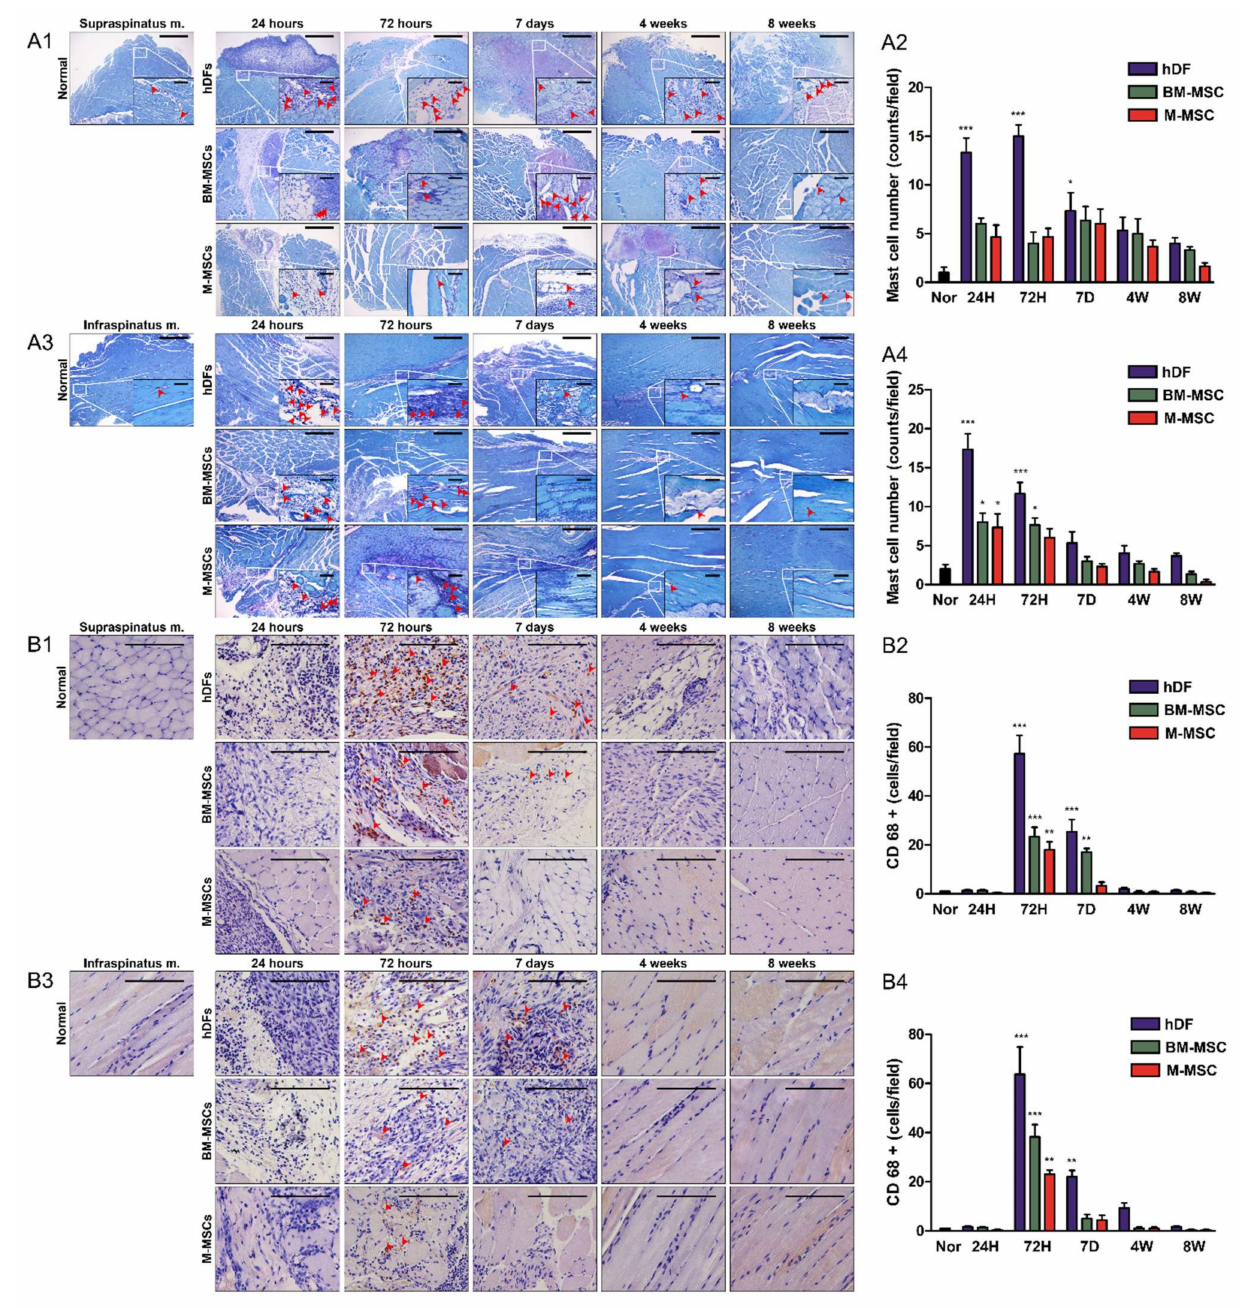
Figure 4. Confirmation of mast cells and CD68+ macrophages. For inflammatory cell counting, muscle samples were excised from hDF (control), BM-MSC and M-MSC groups at 24 h, 72 h, 7 days, 4 weeks, and 8 weeks after RCT induction. To confirm the mast cells, ( A1 , A2 ) supraspinatus and ( A3 , A4 ) infraspinatus muscles were stained with toluidine blue. The scale bars are 500 µ m (50 µ m for HPFs). ( A2 , A4 ) The mast cells were counted in three random HPFs per sample. To confirm the macrophages, ( B1 , B2 ) the supraspinatus and ( B3 , B4 ) the infraspinatus muscles were immuno- histochemically stained with anti-CD68 antibody. The scale bars are 100 µ m. ( B2 , B4 ) The CD68+ macrophages were counted in three random HPFs per sample. The data are shown as mean ± SD and the significance was represented as * p < 0.05; ** p < 0.01; *** p < 0.001,